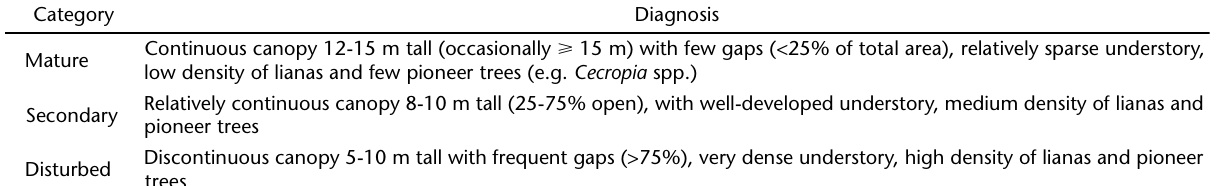
Table II. Habitat categories used to classify the vegetation within the trail system in each forest fragment at the Fazenda Trapsa, Sergipe, Brazil. Based on C HAGAS & F ERRARI (2010). Category